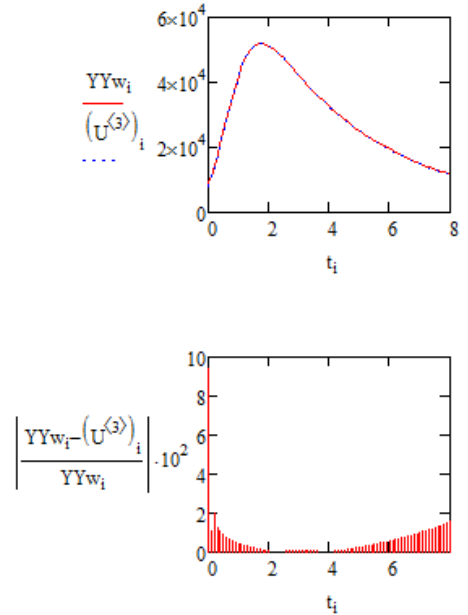
Fig. 2. Comparison of the estimated solutions, Y Y vw i , with the “experimental data”, U < 4 >